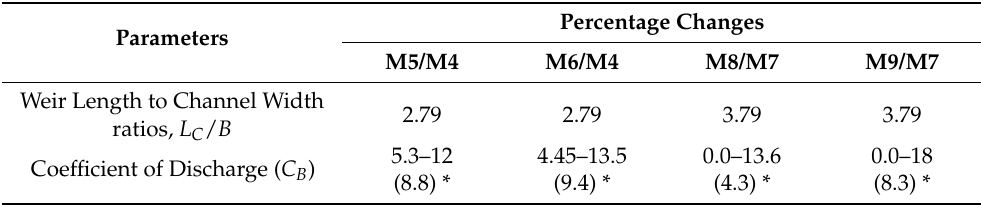
Table 4. Changes in the C B values due to the weir height.